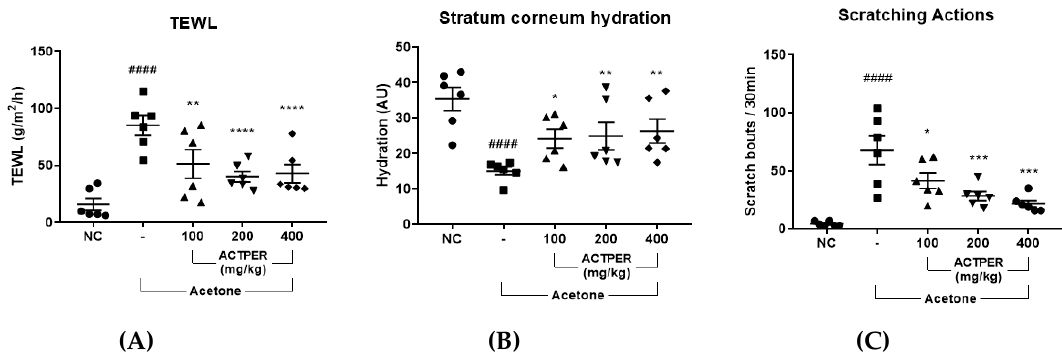
Figure 3. ACTPER alleviates dry-skin induced itch in acetone-treated mice. Effect of ACTPER on ( A ) Transepidermal water loss (TEWL), ( B ) Stratum corneum (SC) hydration and ( C ) scratching behaviors. n = 6 per group. All data are shown as mean ± S.E.M. #### p < 0.0001 compared with control group; * p < 0.05, ** p < 0.01, *** p < 0.001, **** p < 0.0001 compared with vehicle group.